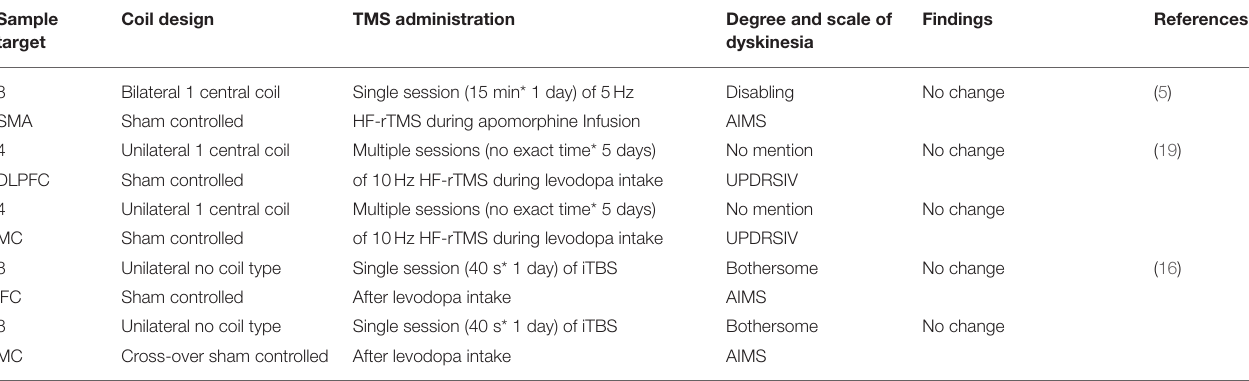
TABLE 2 | Overview of excitatory TMS (HF rTMS/iTBS) for the treatment of LID in PD. Sample